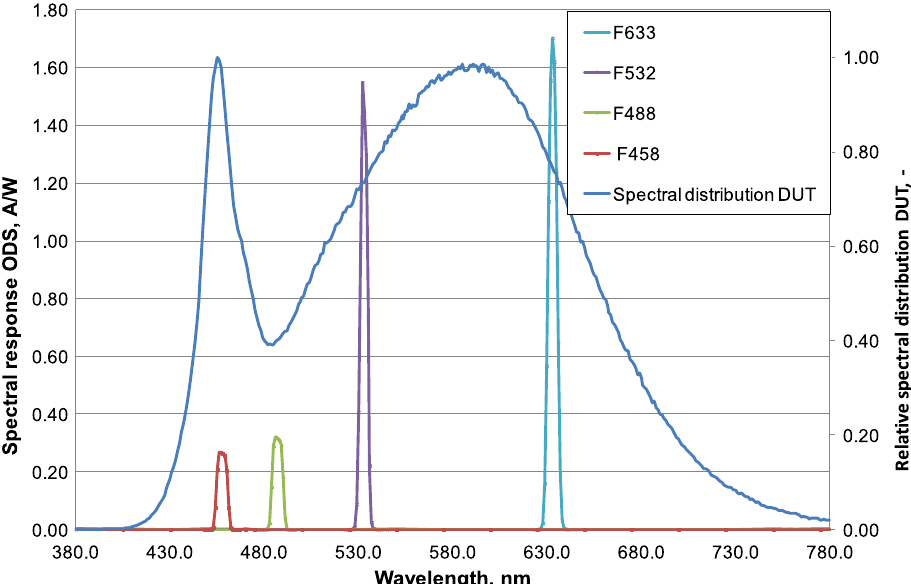
Fig. 4. Absolute Spectral Responsivity of the ODS fi lters F633, F532, F488 and F458 (A/W), and the relative spectral distribution power of a DUT normalized to maximum (secondary axis).